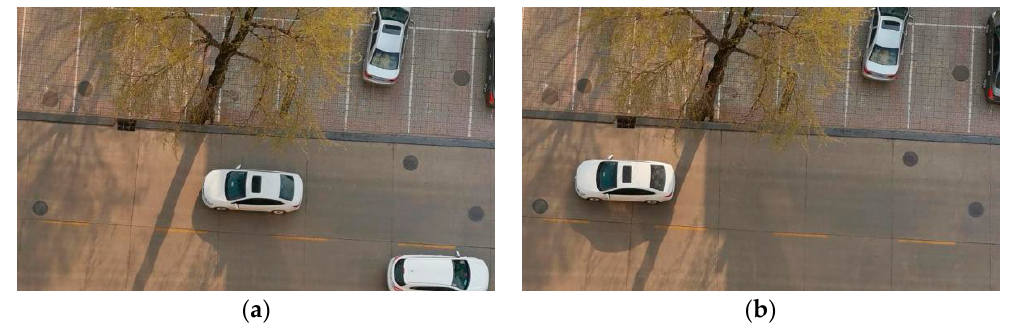
Figure 4. Two adjacent images captured by UAV: ( a ) the first image; ( b ) the second image.